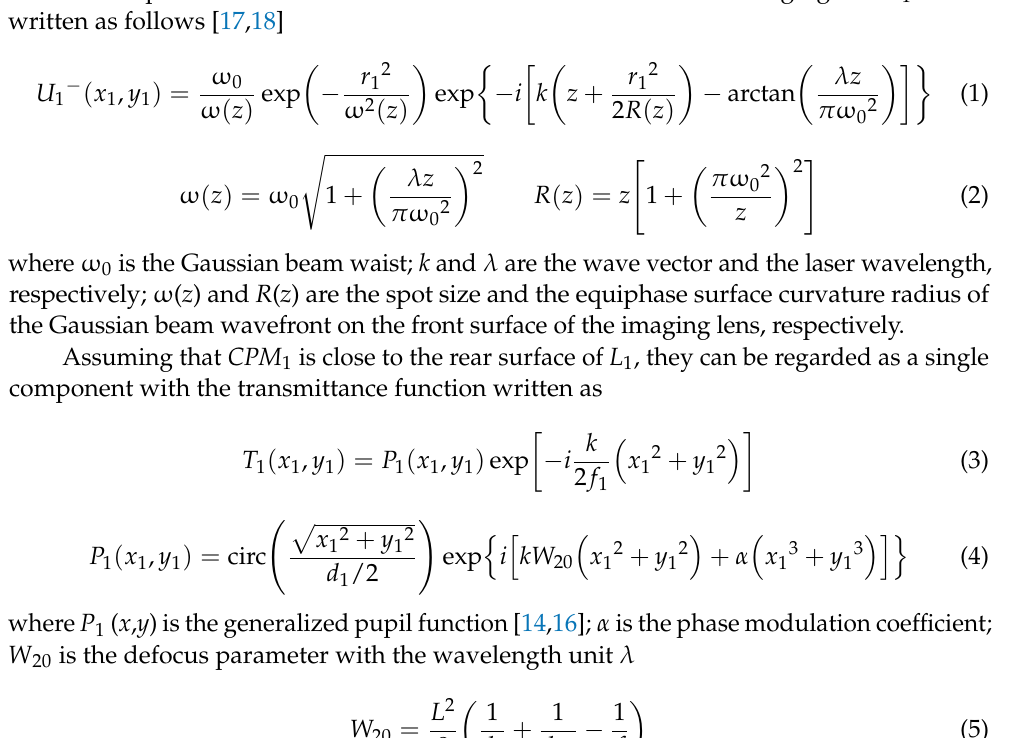
Figure 2. Equivalent physical model of retroreflection in wavefront coding imaging system. The amplitude distribution of the beam on the surface of the imaging lens L 1 can be